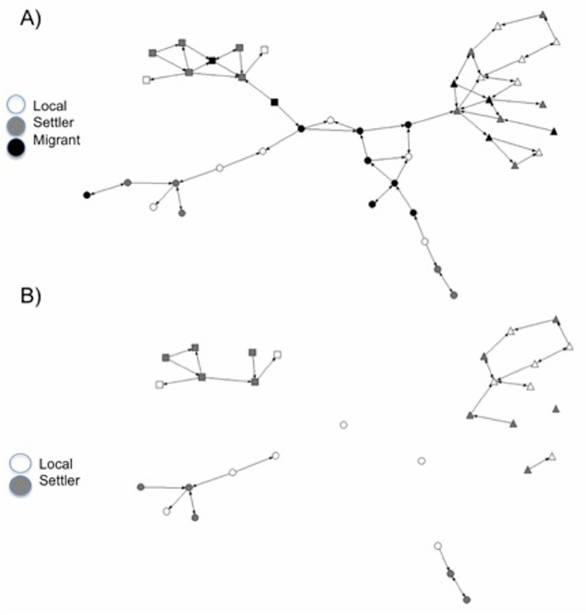
Fig. 3. Network diagram of agroecosystem management information ties for the study area, Sunyani District, Brong Ahafo Region, Ghana. (A) All individuals, including locals, settlers, and migrants. (B) Migrants removed. The shape of the node differentiates the geographic location: circle = locality 1, triangle = locality 2, square = locality 3.